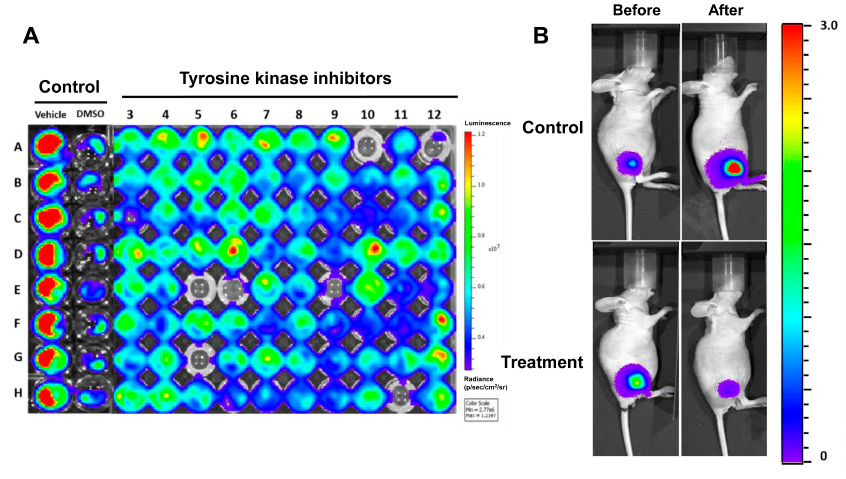
Figure 3. Drug screening and therapeutic drug monitoring by Bioluminescence imaging (BLI). ( A ) Drug screening by BLI. Stable luciferase (FLuc)-transfected cancer cells can be used for high throughput screening (HTS). FLuc activity of cancer cells treated with 5 μ M tyrosine kinase inhibitors screening (HTS). FLuc activity of cancer cells treated with 5 µ M tyrosine kinase inhibitors was